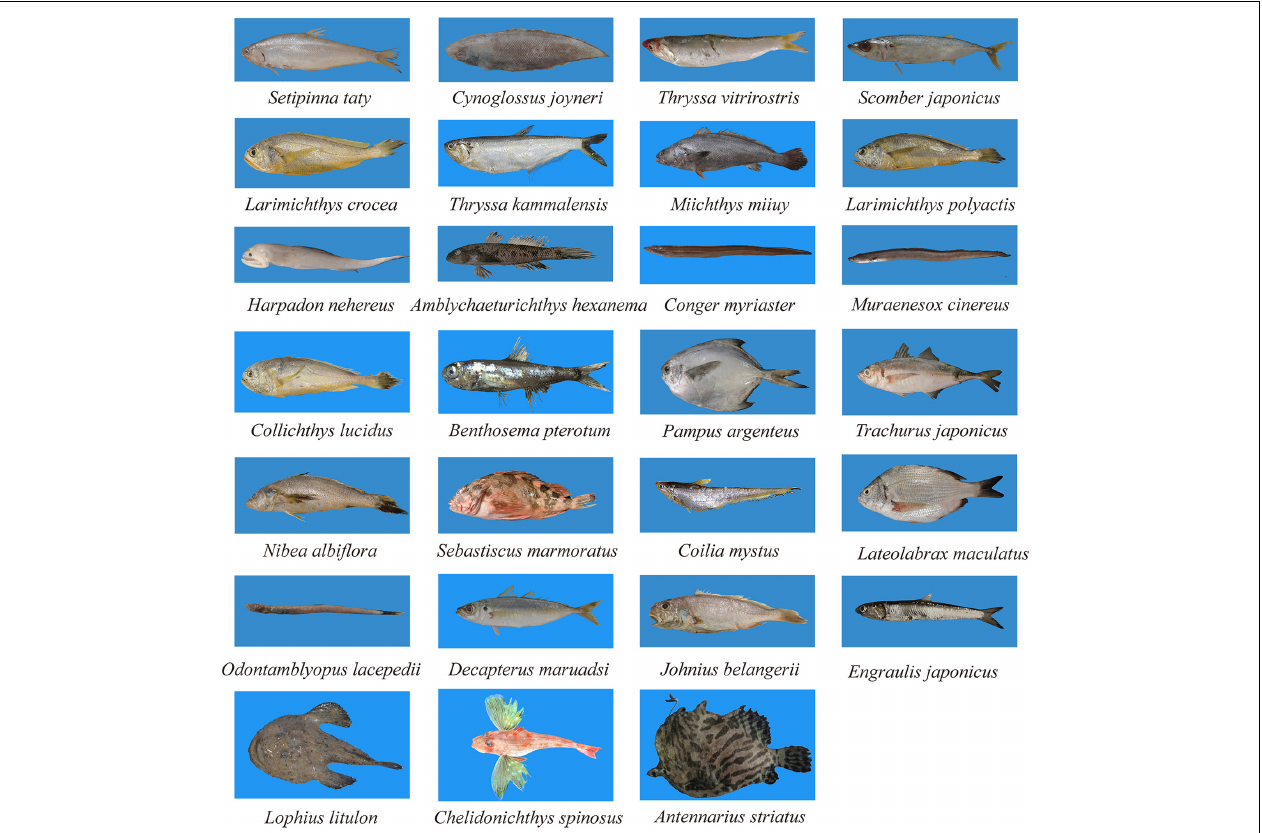
FIGURE 5 | The 27 fish species identified by both eDNA metabarcoding and bottom trawling in the Zhoushan Sea